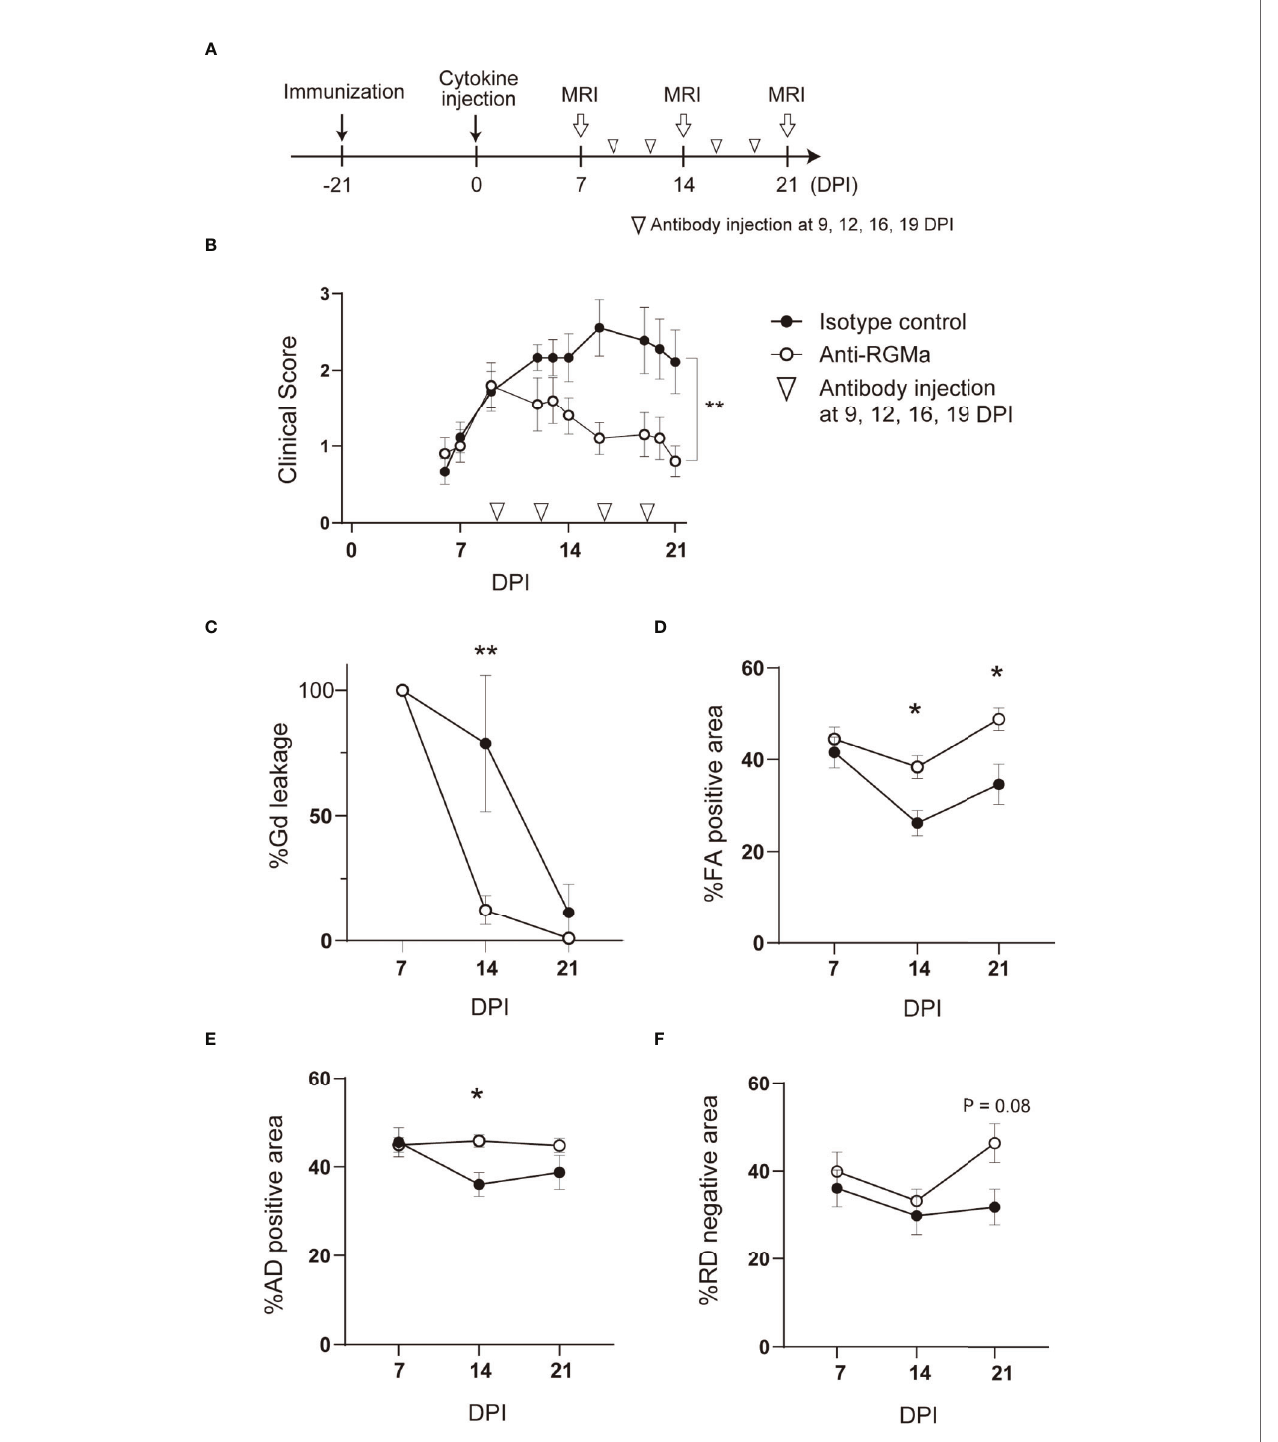
FIGURE 2 | Humanized anti-RGMa antibody ameliorates the neurological symptoms and MRI parameters in targeted EAE mice (A) Experimental time course. (B) Anti-RGMa antibody treatment signi fi cantly improves clinical score (isotype control; n=9, anti-RGMa; n=10, Mann-Whitney test). (C) Anti-RGMa antibody attenuates %Gd leakage at 14 DPI (isotype control; n=8, anti-RGMa; n=9, two-way ANOVA followed by Bonferroni ’ s multiple comparison test). (D – F) Effect of anti-RGMa antibody on %FA positive area, %AD positive area, and %RD negative area (isotype control; n=9, anti-RGMa; n=10, two-way ANOVA followed by Bonferroni ’ s multiple comparison test). Error bars represent the mean ± SEM. * p < 0.05, ** p <